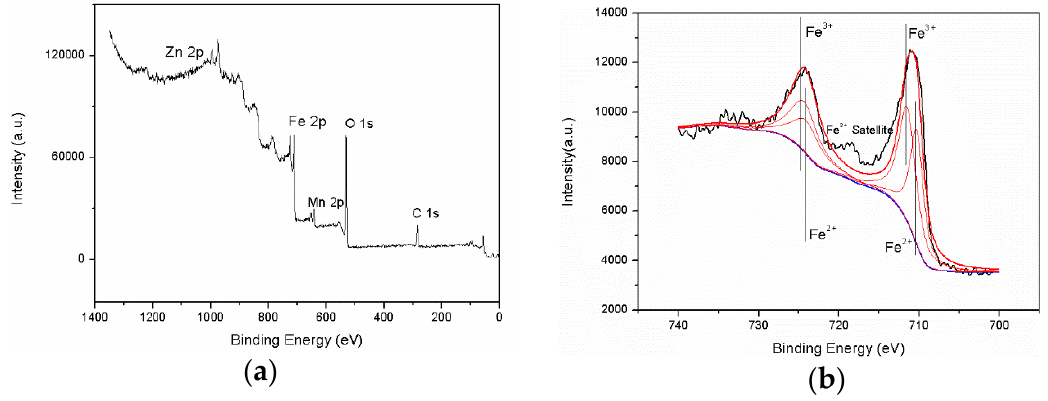
Figure 5. ( a ) XPS spectra of Fe 3 O 4 -MnZnFe 2 O 4 coated iron powders, ( b ) fitted Fe 2p peaks.